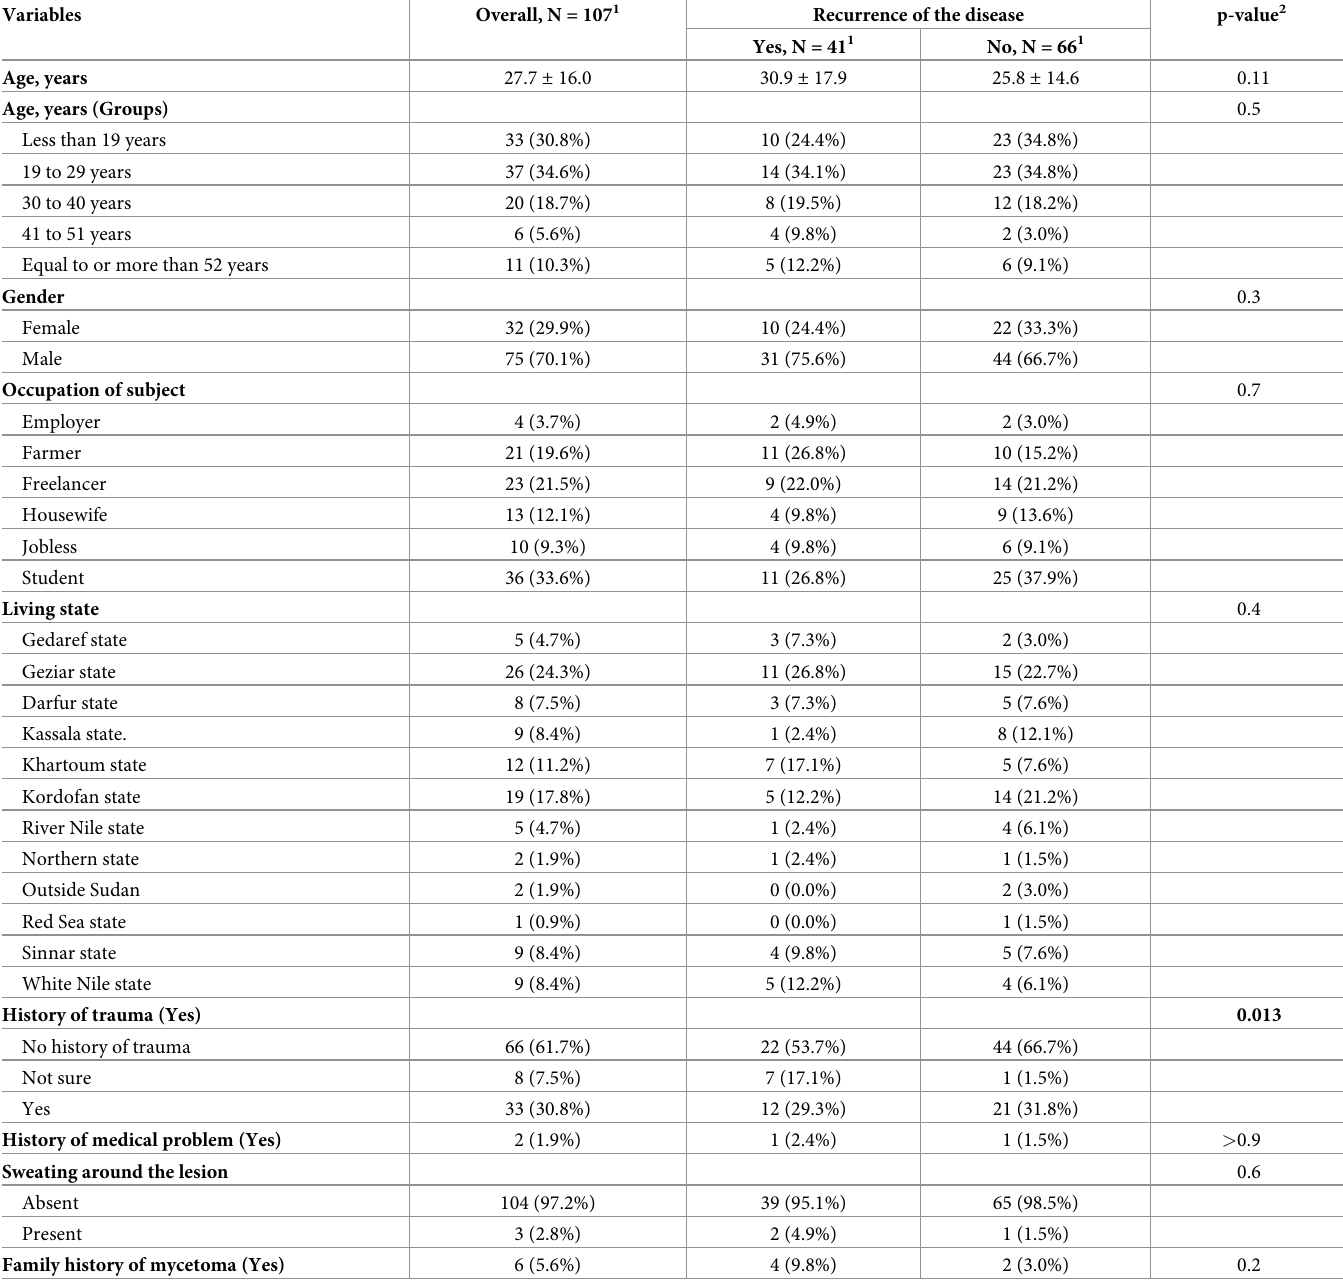
Table 1. Baseline characteristics and clinical history of participants with mycetoma. (n = 107).